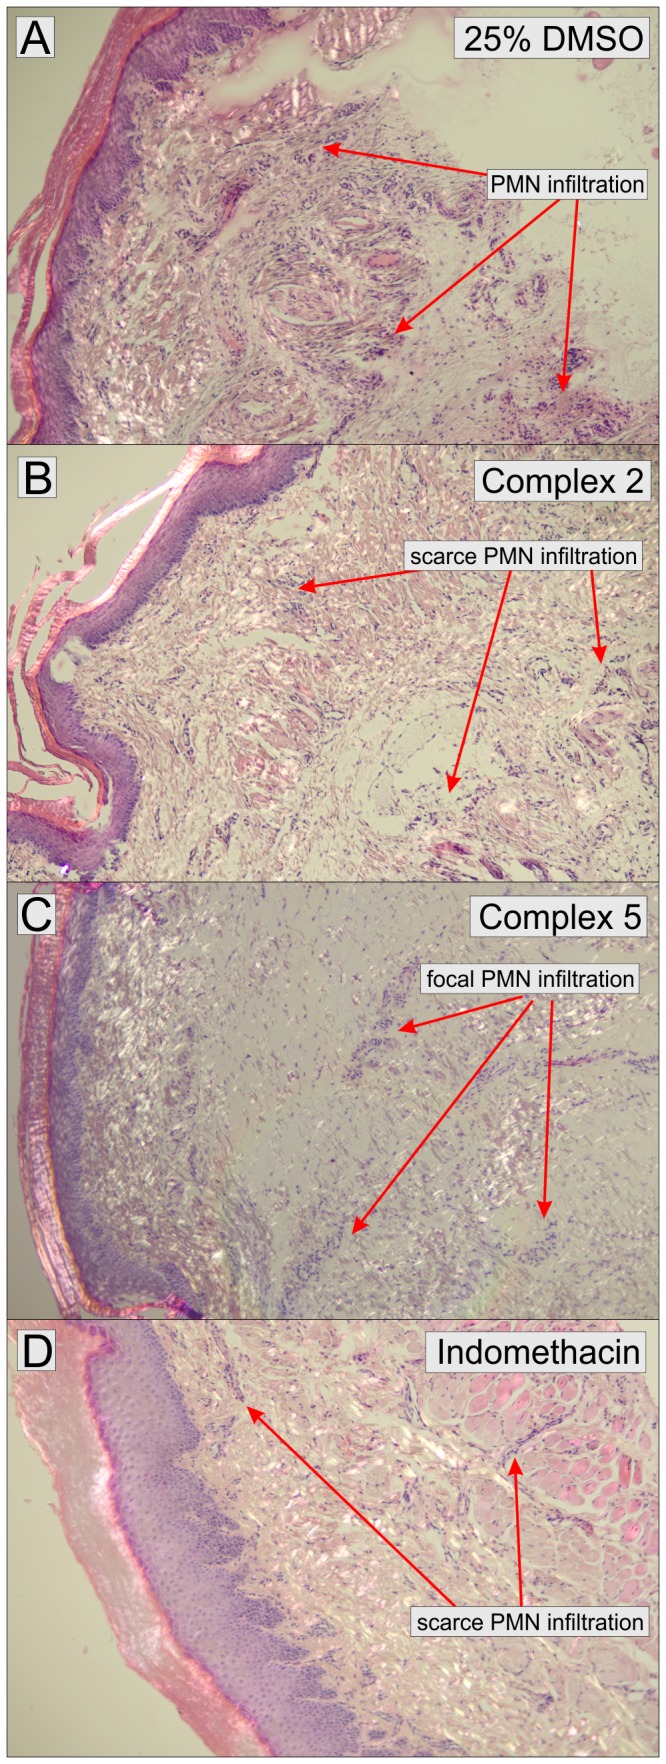
Histological evaluation of inflammatory response in tissue sections of the hind paw, stained with Hematoxylin – eosin (40x magnification).Tissue exposed to 25% DMSO (control; A) and complex 5 (C) with the acute inflammatory reaction dermis and hypodermis with a massive infiltrate of neurophils (PMN); tissue exposed to complex 2 (B) and Indomethacin (D) with the inflammatory reaction in the hypodermis with scarce PMN infiltrate.